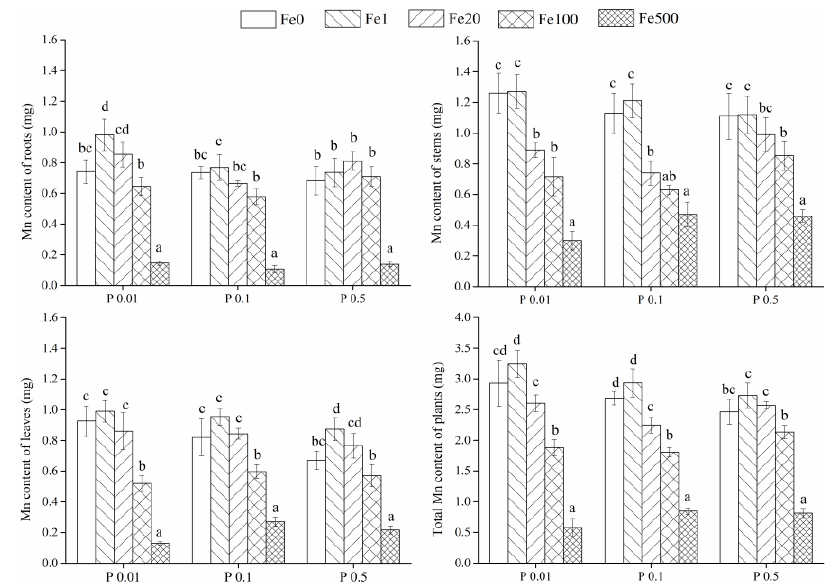
Figure 5. Effects of Fe 2+ and P on roots, stems, leaves, and total Mn contents of G. spiculosa . Values (mean ± SE, n = 3) followed by different letters designate significant differences ( p < 0.05) between Fe 2+ concentrations for a given P level (a, b, c, d).